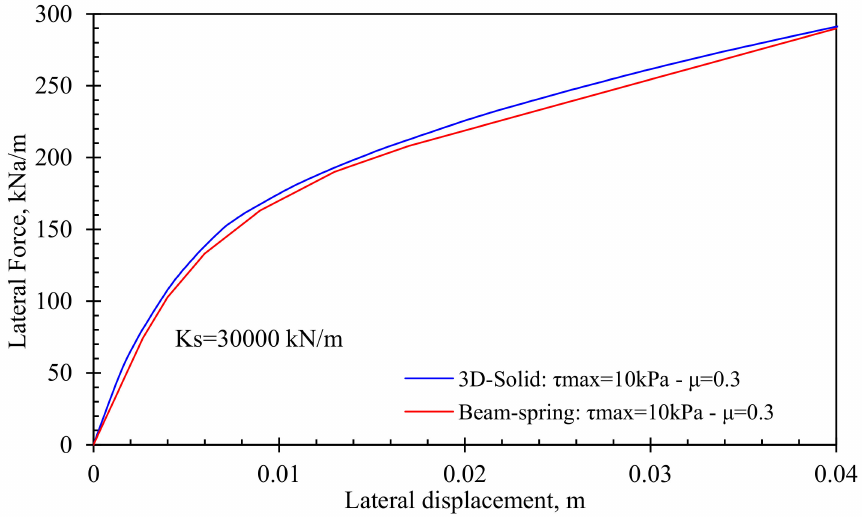
Figure 9. Lateral soil–pipe force–displacement curve of the beam–spring model versus the 3D solid model in a lateral sliding test with a contact friction coefficient of